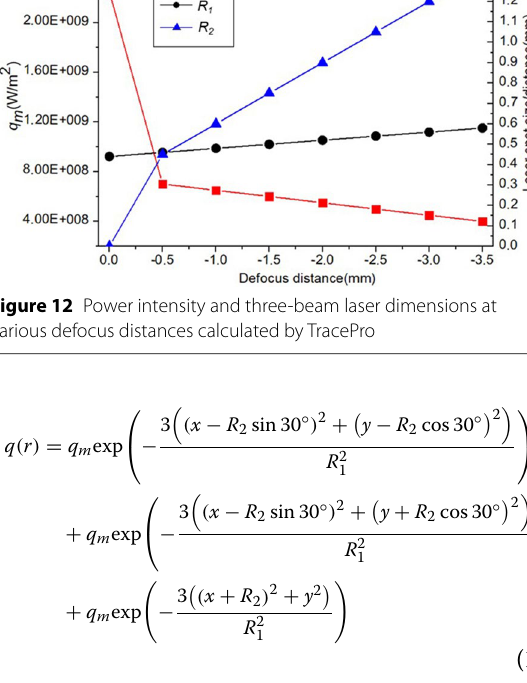
Figure 12. The dimensions of each beam and laser spot